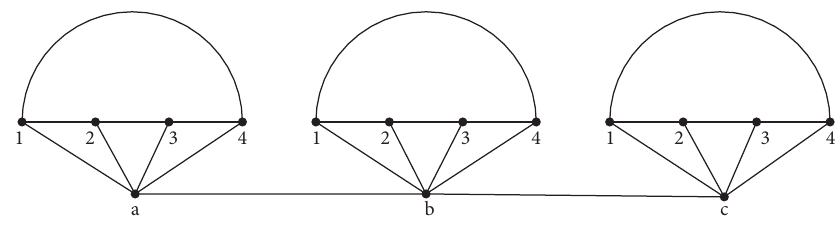
Figure 2: The graph of G � P